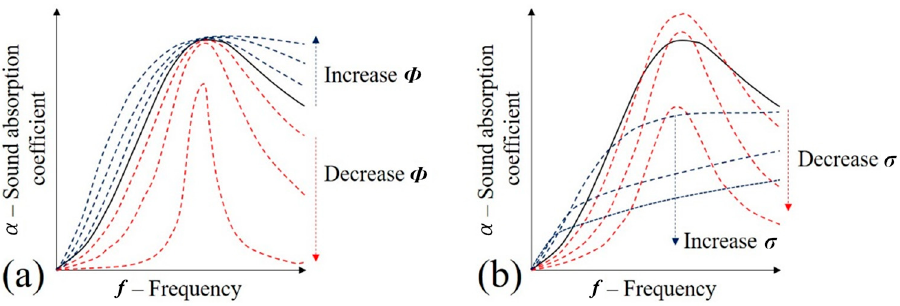
Figure 13. Influence of visco-inertial parameters in the sound absorption coefficient of porous me- dia (JCAL model): ( a ) Ф —porosity; and ( b ) σ —air flow resistivity. According to Darcy’s law (Equation (10)), the decrease in porosity may increase the static air flow resistivity ( σ ) for a given pressure gradient ( ∇(cid:4652)(cid:4652)⃗𝑃 ) and fluid velocity ( 𝑣⃗ ) [39].